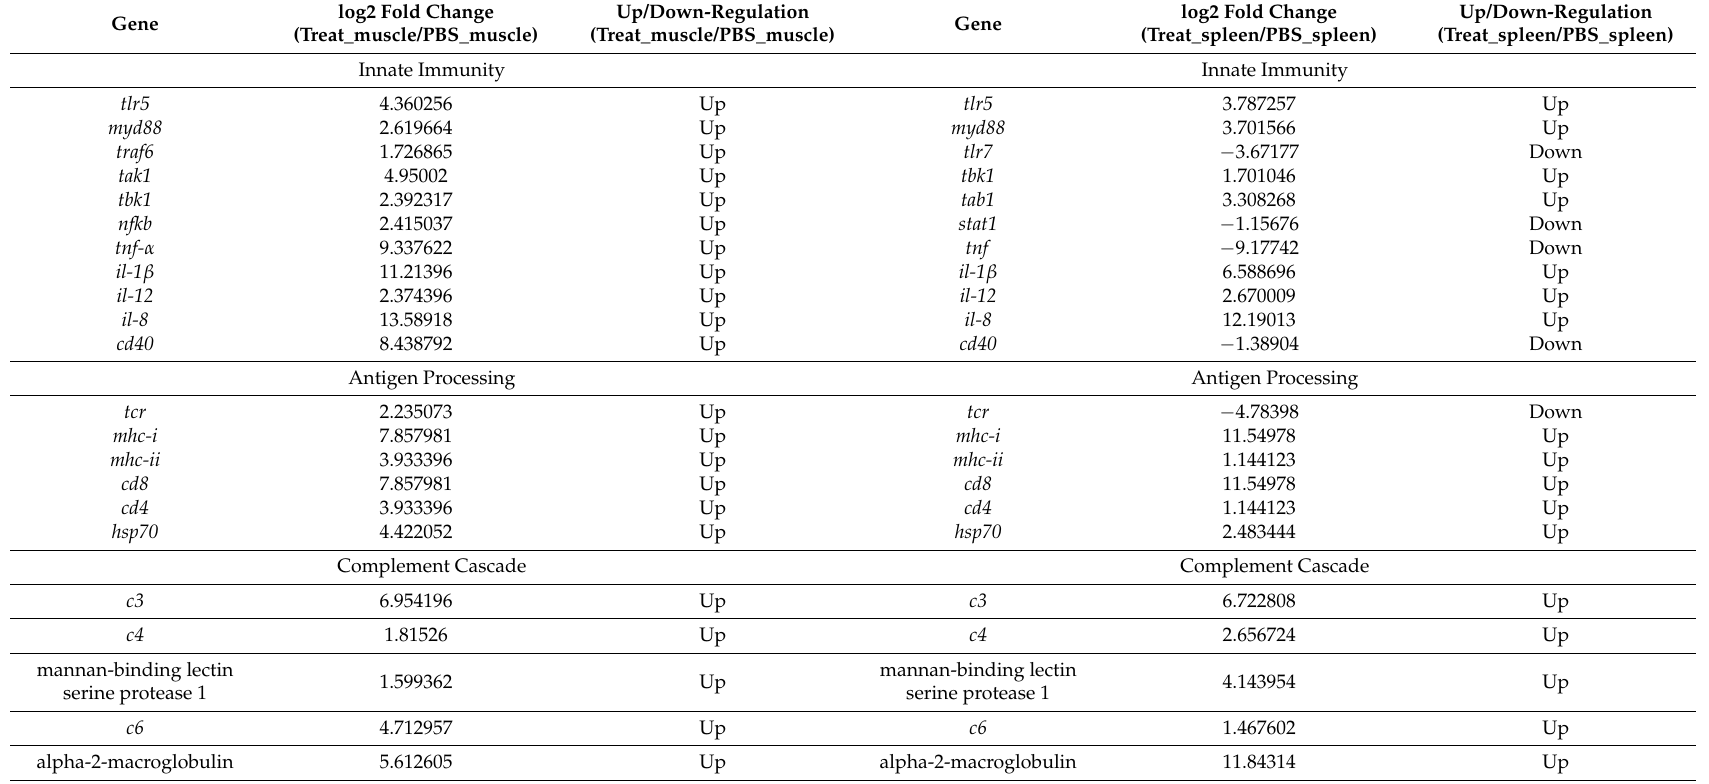
Table 1. Immune-related DEGs regulated after infection in muscle and spleen of koi